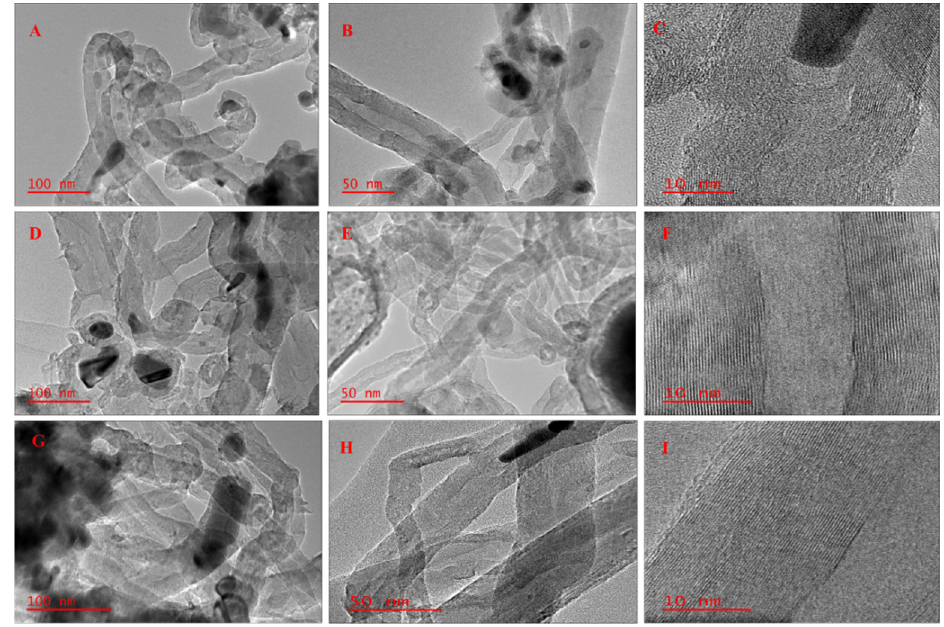
Figure 6. TEM micrographs of synthesized CNMs. ( A – C ) CNT 0 ; ( D – F ) CNT X and ( G – I ) CNT T .